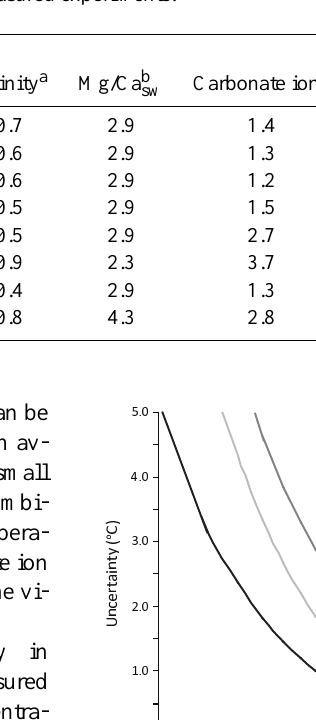
Table 3. Mg/Ca standard deviation ( σ , as percentage of the average) based on the measured standard deviation of each parameter during the experiments. Standard deviations from Table 1 are used and converted to Mg/Ca values using the same Mg/Ca parameter relations as (a) Due˜nas-Boh´orquez et al. (2009) (0.11 · Salinity+1.00), (b) Wit et al. (2012) (Mg/Ca= a · R · e (b · T) ) , and (c) Due˜nas-Boh´orquez et al. (2011b) (0.0012 · [CO 2 − ]+1.50). Not all experiments had Mg/Ca sw data, experiments without Mg/Ca sw measurements were assumed to 3 have variability according to the average variability of the measured experiments.